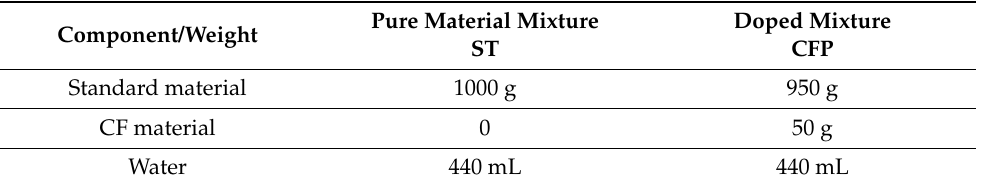
Table 1. Components used for the preparation of the bentonitic grout mixtures with CFP as additive. Component/Weight